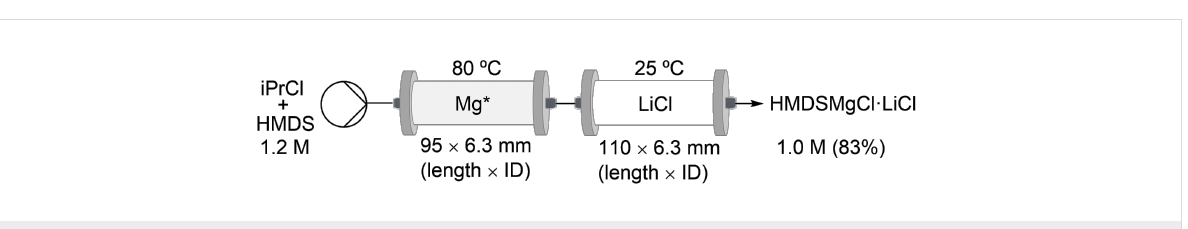
Scheme 5: Synthesis of HMDSMgCl ⋅ LiCl on the ODR